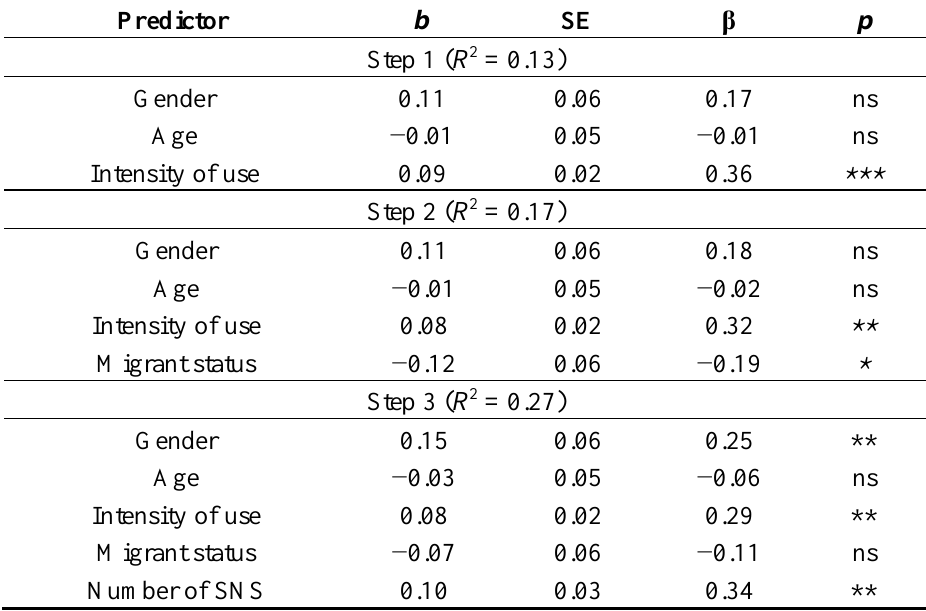
Table 4. Summary of regression results for predicting Orkut network size from migrant status and simultaneous SNS use, controlling for age, gender and intensity of